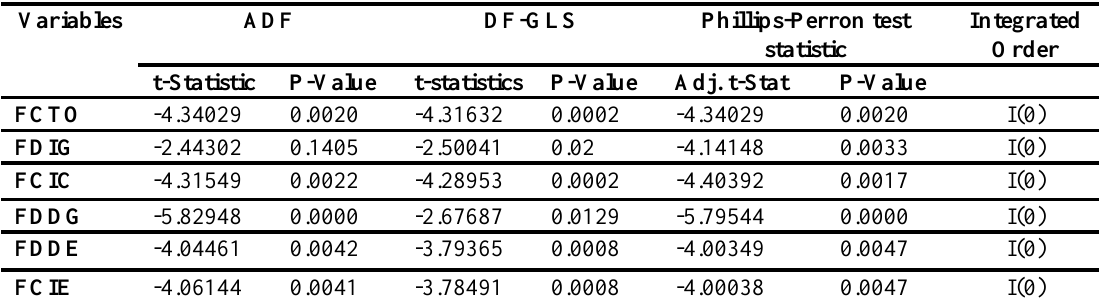
Table.1.Unit Root